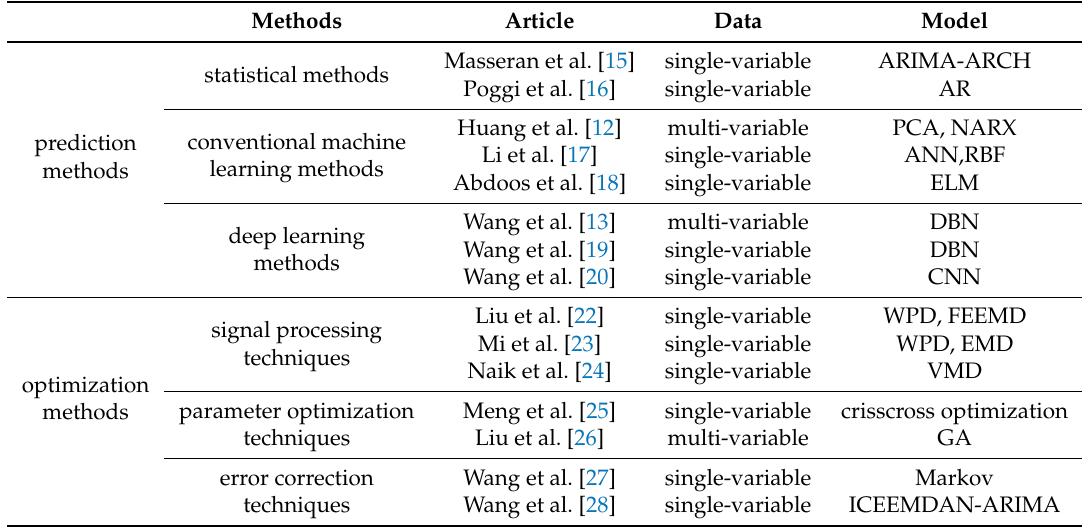
Table 1. A summary of existing algorithms related to the proposed hybrid